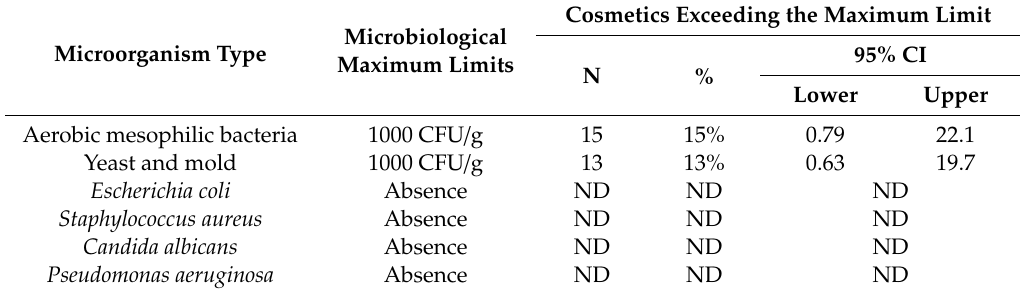
Table 3. Estimation of the microbial contamination rate in the sampled cosmetics and personal care products ( n = 100).